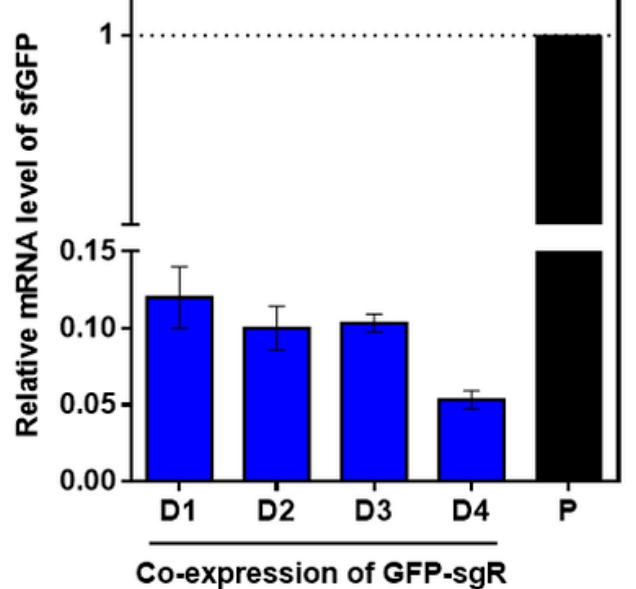
Figure 4. Quantification of sfGFP mRNA by qRT-PCR. P, L. citreum JW001; D1, L. citreum JW001